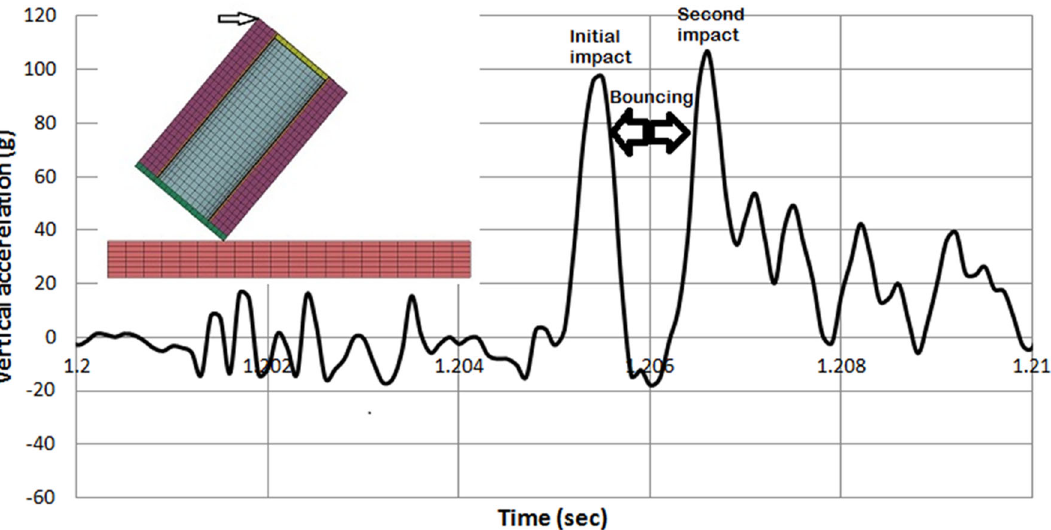
Fig. 27 Time history of vertical acceleration at the tip of the